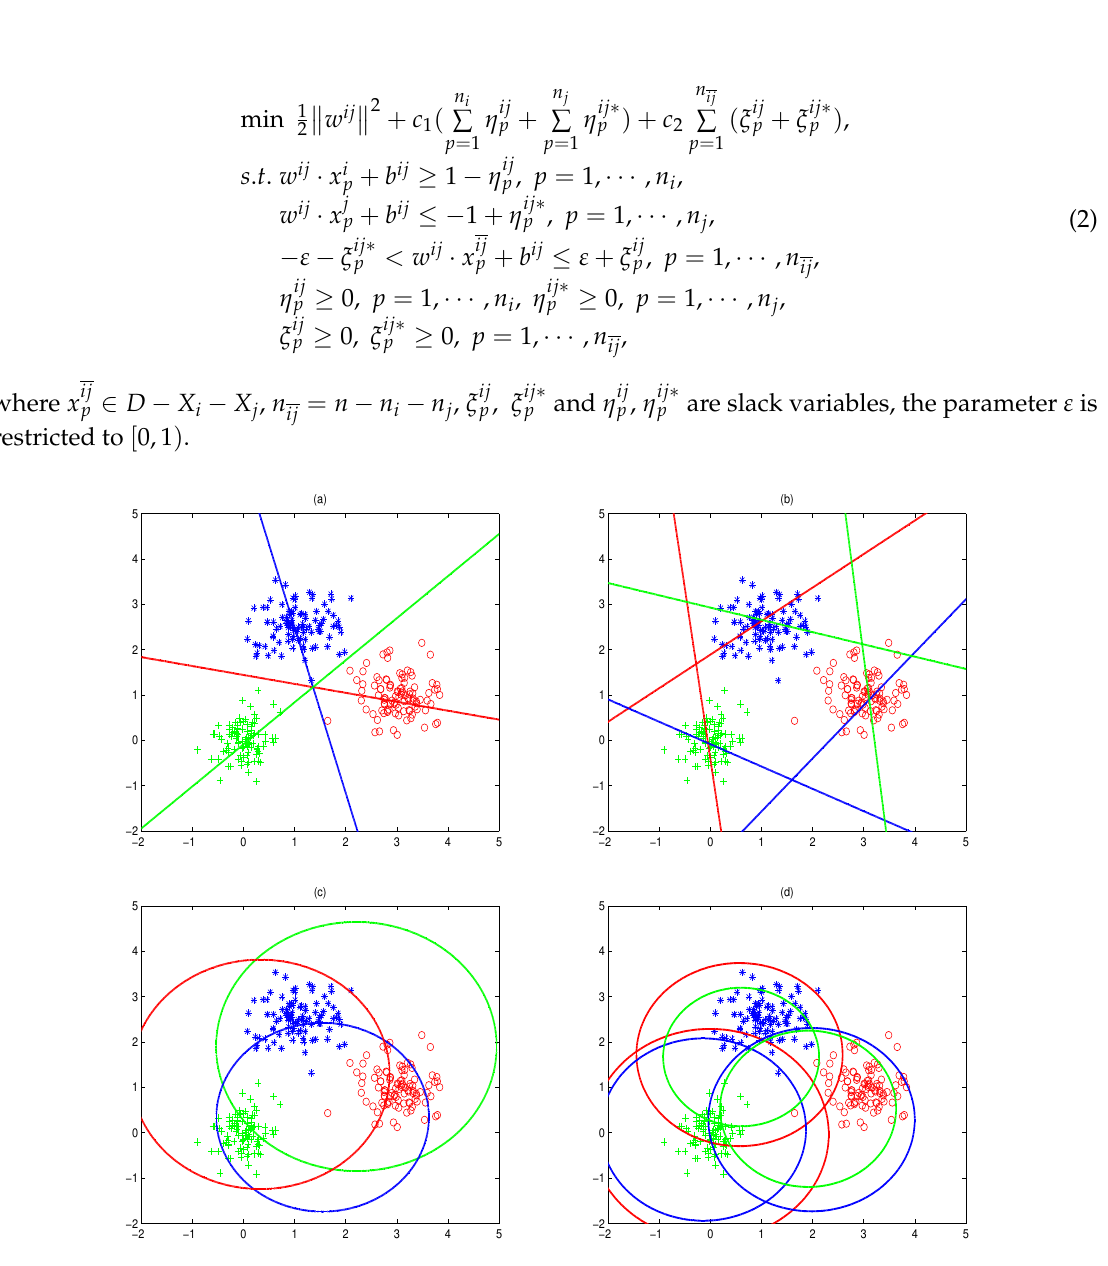
Figure 1. ( a ) K-SVCR. ( b ) Twin-KSVC. ( c ) THKSVM. ( d ) Twin